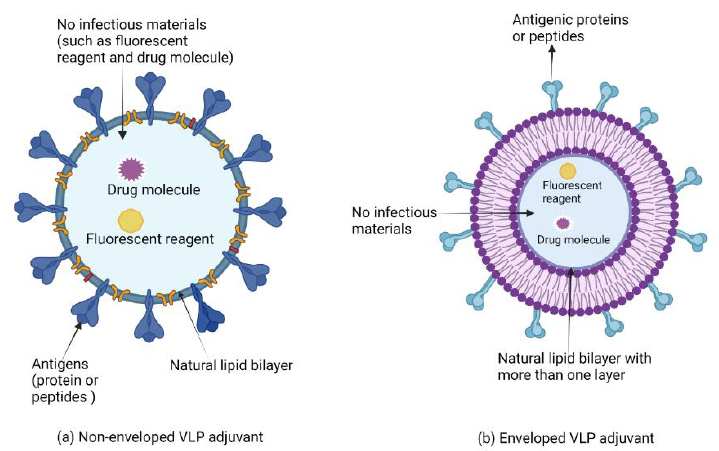
Figure 4. Schematic of a virus-like particle (VLP), where the surface is made up of antigens (e.g., capsid proteins) that have been embedded into the natural lipid bilayer (surrounding cell membrane) to form enveloped VLPs. ( a ) Non-enveloped VLPs contain single or multiple capsid proteins only. Neither type of VLP contains infectious material (e.g., DNA/RNA). ( b ) The formulation of double layer enveloped VLPs is related to the multiple glycoproteins on their